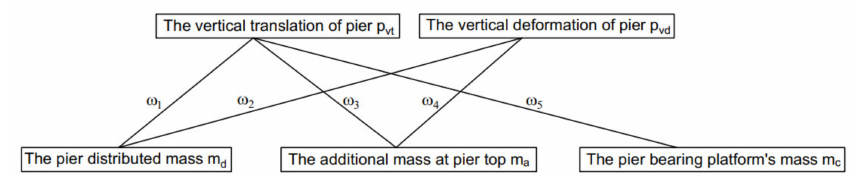
Figure 2. Combinations of vertical displacement elements and mass